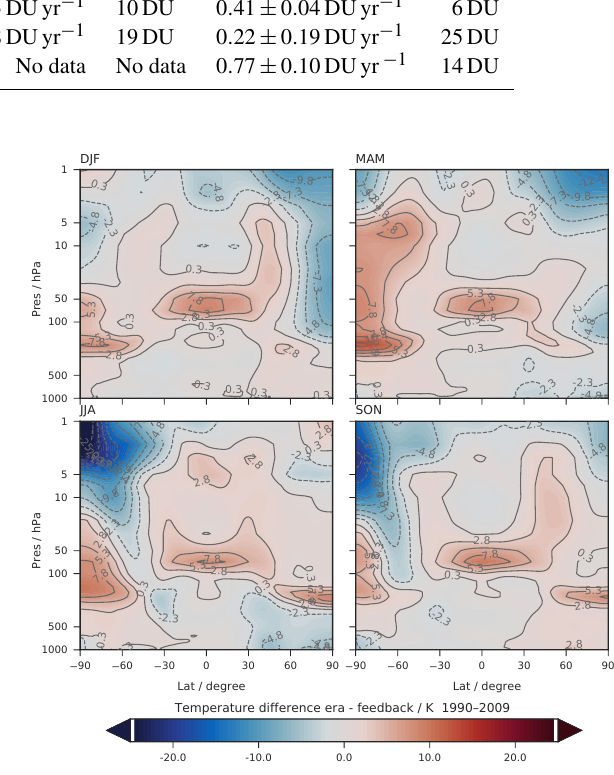
Figure 10. Latitude–height cross sections of seasonal and zonal mean temperature differences (K) for ERA-Interim minus feedback